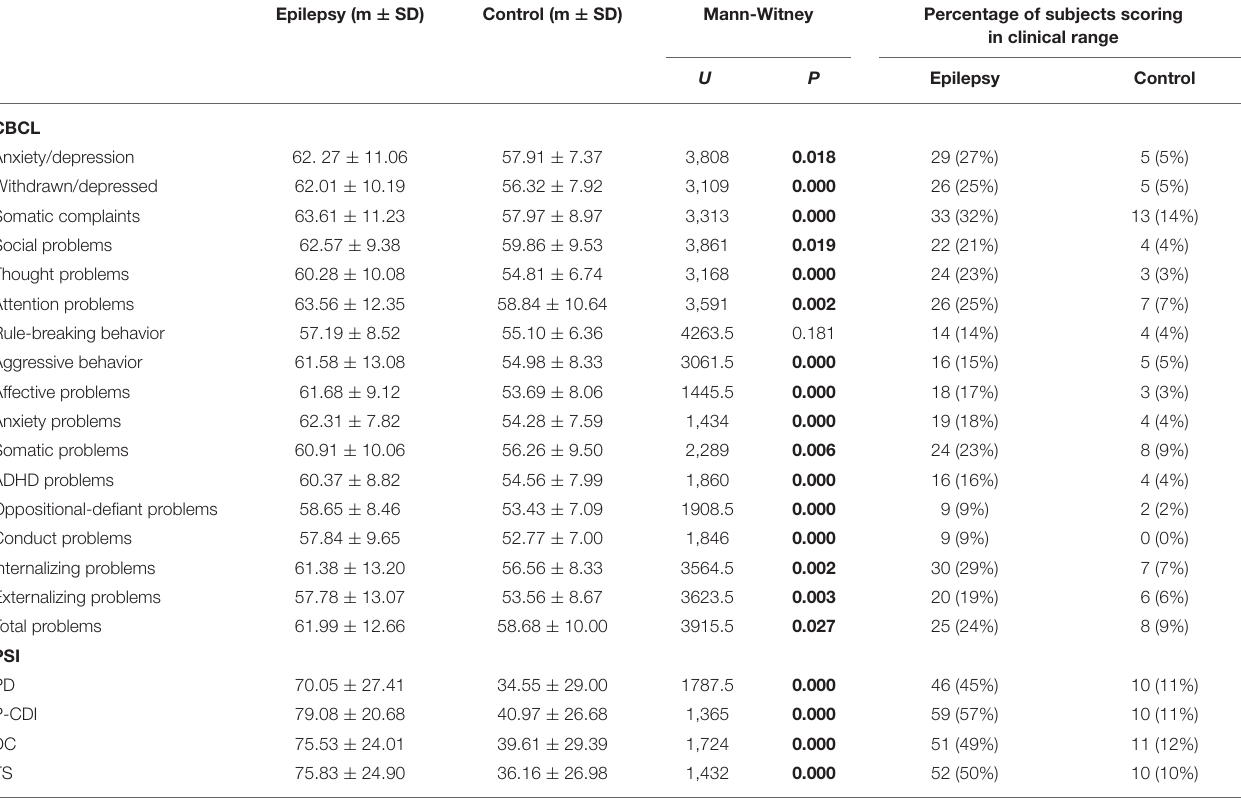
TABLE 2 | Statistical comparison between the average scores of the different groups. Epilepsy (m ± SD) Control (m ± SD) Mann-Witney Percentage of subjects scoring in clinical range U P Epilepsy Control